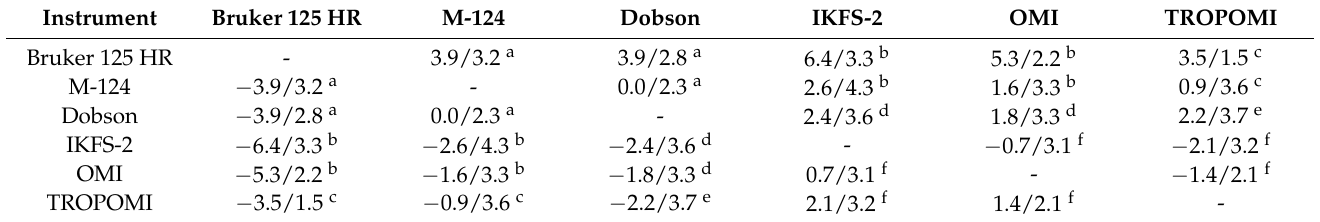
Table 3. Statistical characteristics of the differences between TOC observation data near St. Petersburg for several time spans in the 2004–2020 period. MD and SDD of the difference relatively to Dobson mean TOC are shown in %. Letters in the cells mark different time spans in which the data are